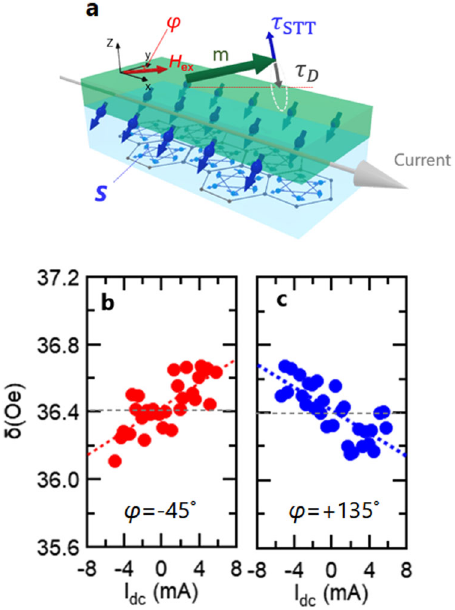
Fig. 3 Modulation of effective magnetic damping by spin Hall effect in Mn 3 Sn. a Schematic image of modulation of magnetic damping torque τ D by STT τ STT due to conventional SHE in Mn 3 Sn. The polar angle θ is fi xed at 90°. b , c FMR line width δ at φ = − 45°( b ) and + 135° ( c ) as a function of applied dc τ STT through the formula